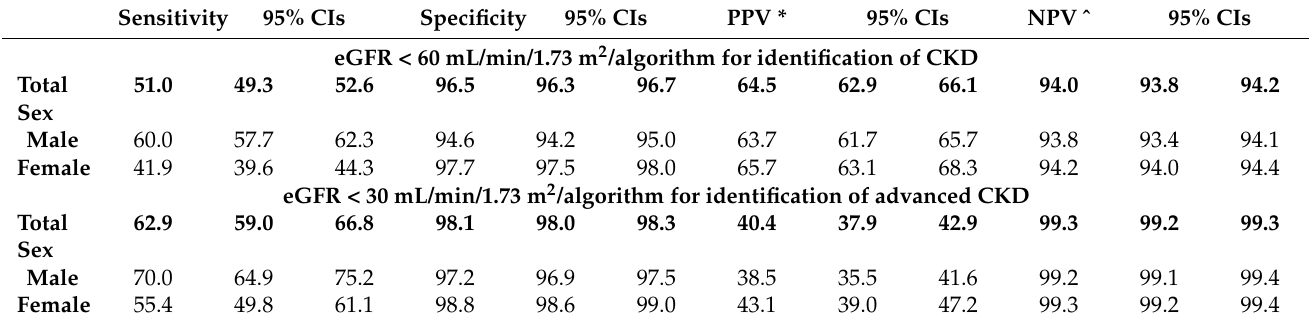
Table 3. Validity of Chronic Kidney Disease (CKD) definitions on administrative data compared with the estimate Glomerular Filtration Rate (eGFR) reference standard, by sex.